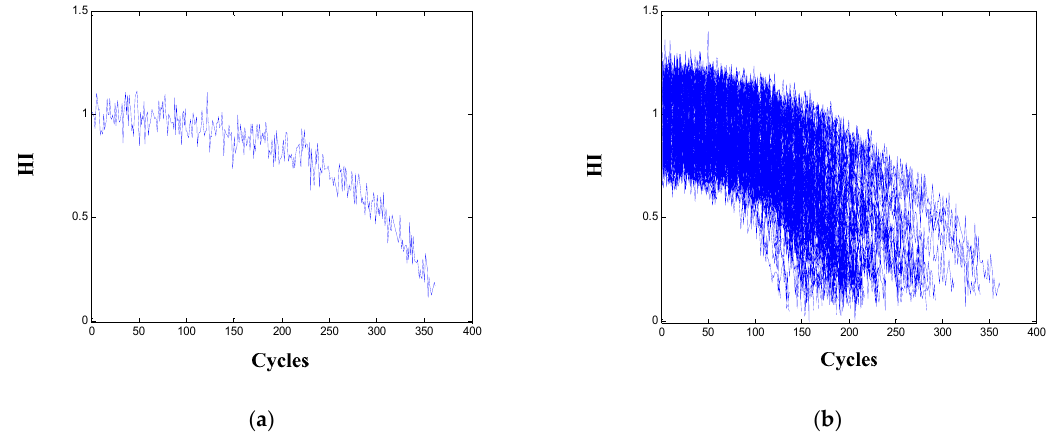
Figure 5. Health index (HI) for: ( a ) one engine; ( b ) all the 100 training engines.